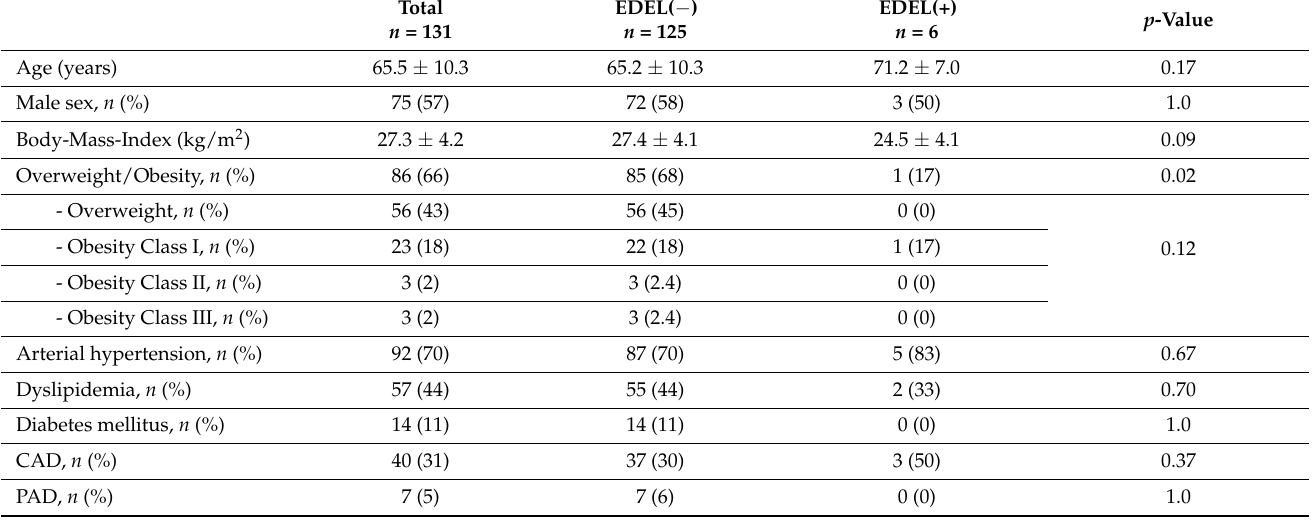
Table 1. Baseline